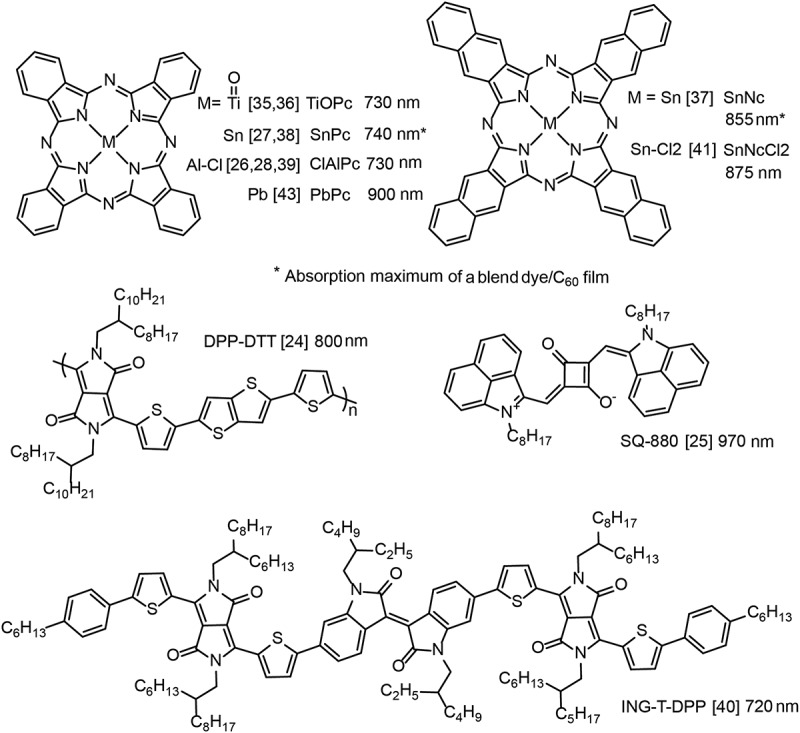
Selected examples of organic NIR sensitizers used in optical upconverters. The indicated wavelengths denote film absorption maxima, as stated in the references or read out from the displayed absorbance spectra. Abbreviated designations for organic compounds were taken from the references.